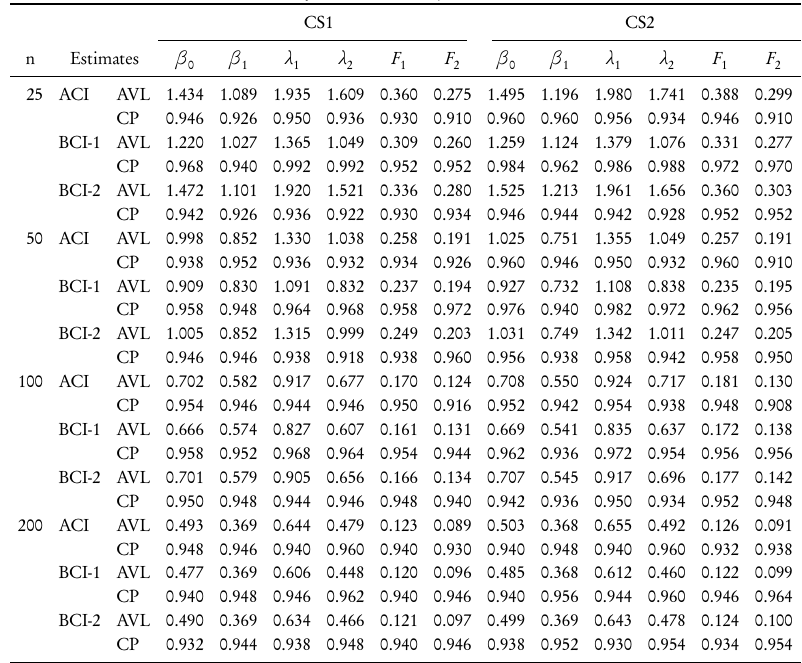
AVL and CP of ACI and Bayes credible